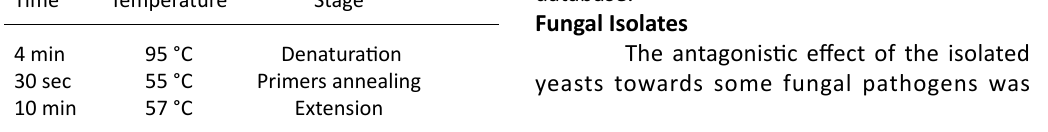
table 1. Thermal circulation conditions of the polymerase chain reaction technique Time